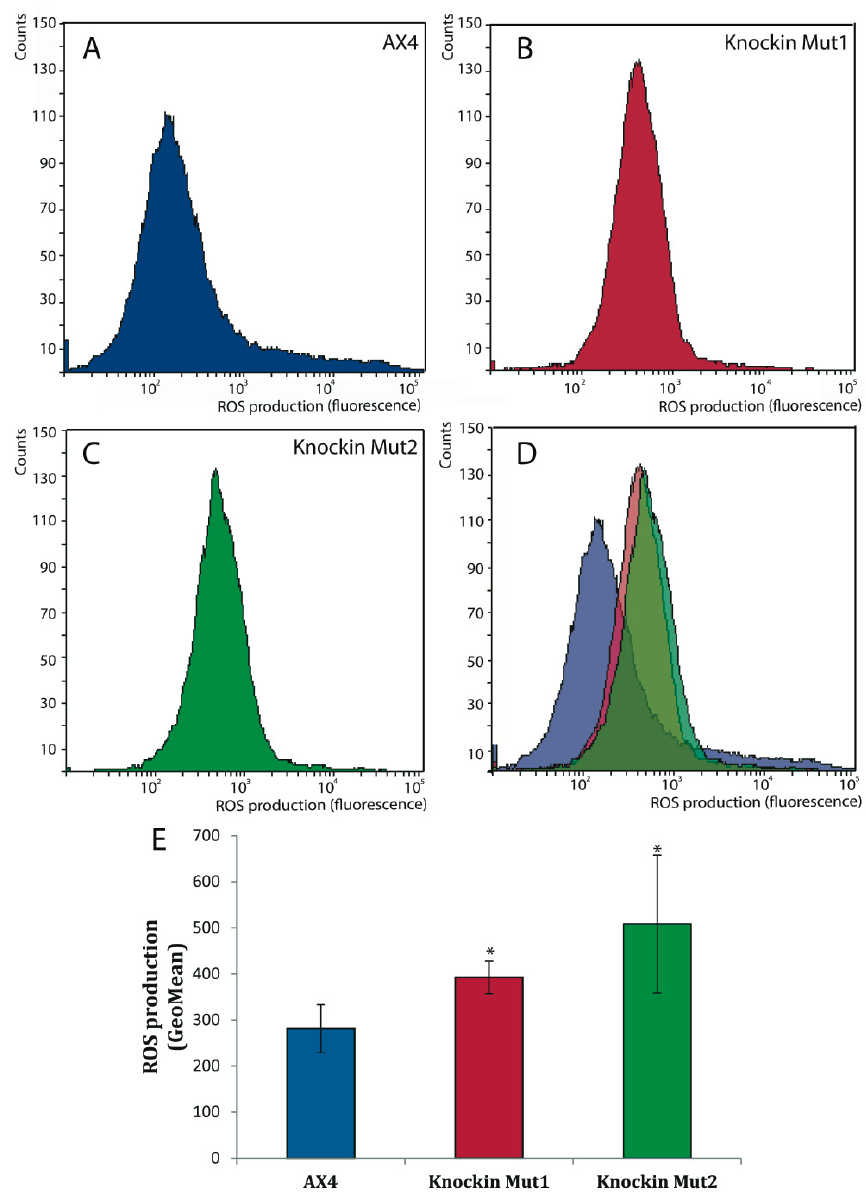
Figure 8. Production of reactive oxygen species by D. discoideum dyskerin mutants. ( A – D ) Wild-type (AX4) and dyskerin mutant strains (knockin Mut1, knockin Mut2) were collected and 10 6 cells analyzed for the expression of reactive oxygen species (ROS) by flow-cytometry using the DHE reagent. Representative diagrams obtained for AX4, knockin 1 and knockin 2 cells are represented in panels A , B and C , respectively and overlapped in panel D . ( E ) The quantification of the data obtained in three independent experiments is represented. Mean values and standard deviations are shown. * p < 0.05.